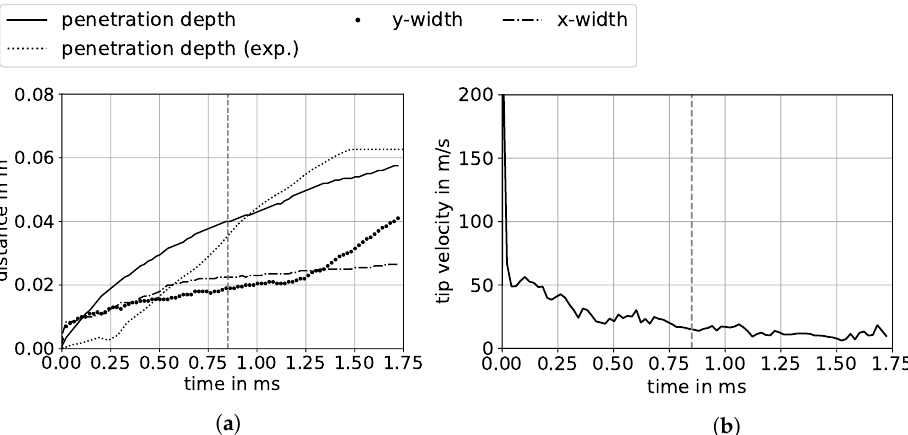
Figure 10. Temporal evolution of the penetration depth and jet width ( a ) and jet tip velocity ( b ). The dashed, vertical line marks the onset of